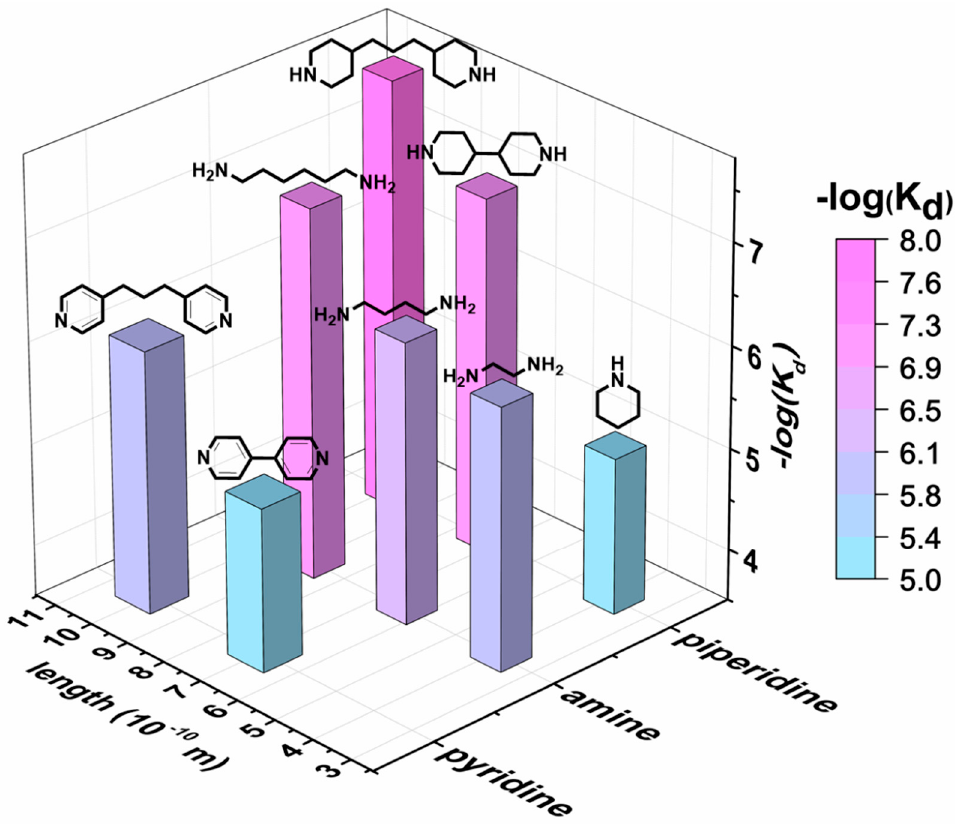
Molecules 2018 , 23 , x FOR PEER REVIEW Figure 4. Comparison of K d values for the complexation of 2 and guests. Figure 4. Comparison of K d values for the complexation of 2 and guests.